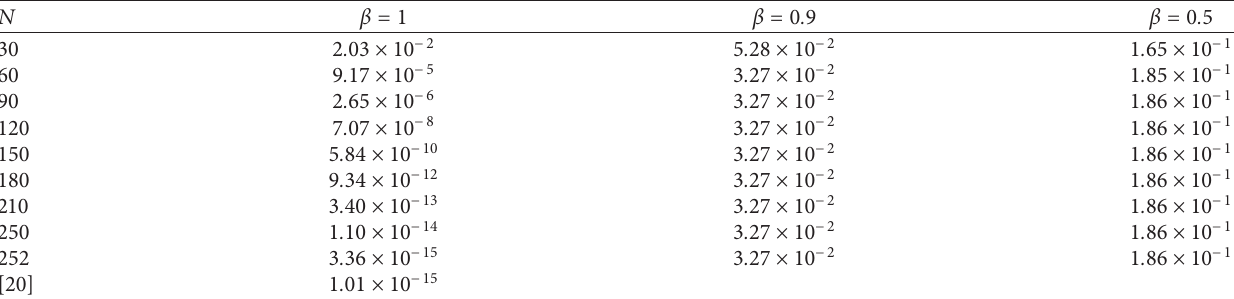
Table 5: The results are obtained for different fractional orders and quadrature nodes N .